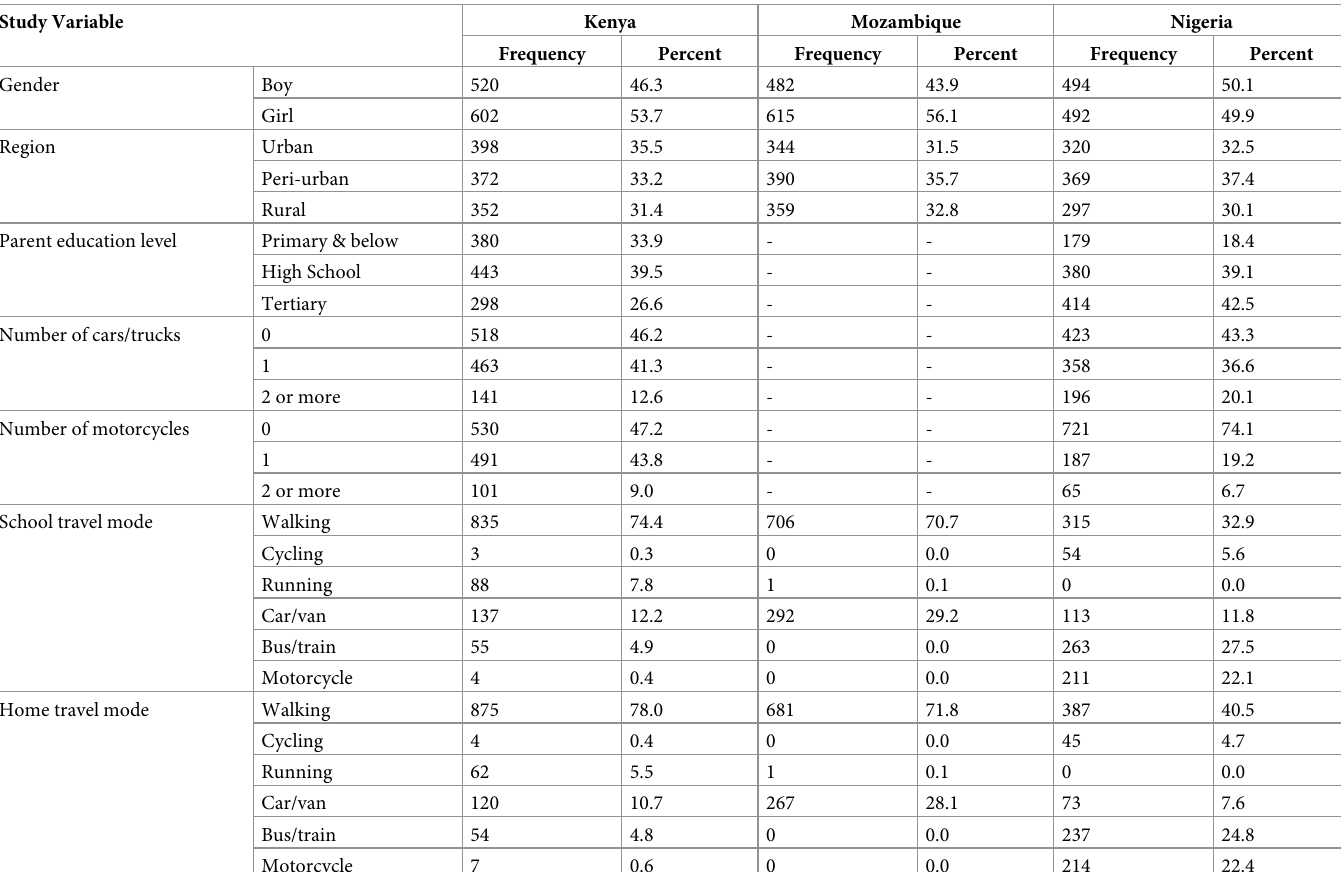
Table 1. Descriptive characteristics of the sample stratified by country. Study Variable